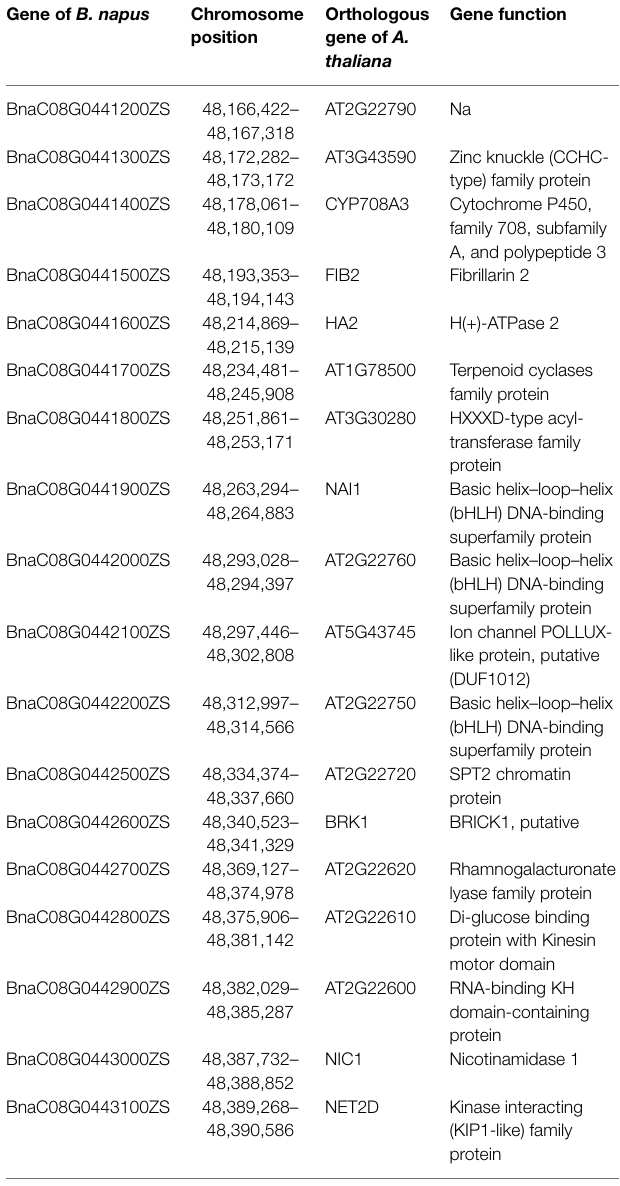
TABLE 2 | Genes on the mapped 228.72 kb interval of “ZS11” reference genome and their annotation. Gene of B.